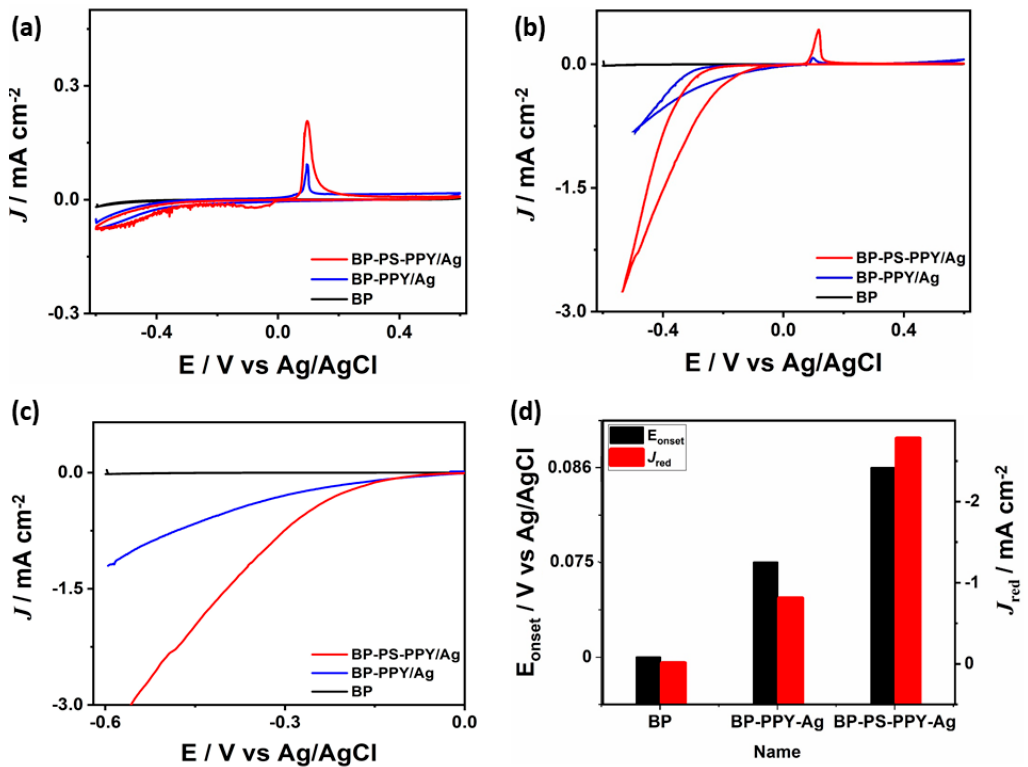
Figure 6. ( a ) Cyclic voltammograms (CVs) measured in an in aqueous solution of PBS (pH 7.4), at a scan rate of 50 mV s − 1 without and ( b ) with 20 µ M H 2 O 2 . ( c ) Linear sweep voltammetry measured in a solution of PBS (pH 7.4) containing 20 µ M H 2 O 2 at a scan rate of 50 mV s − 1 . ( d ) Comparison of the different E Onset and J Red .